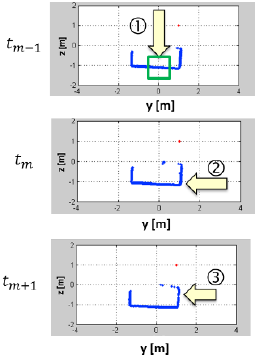
Figure 13. Altitude estimation using vertical scans.